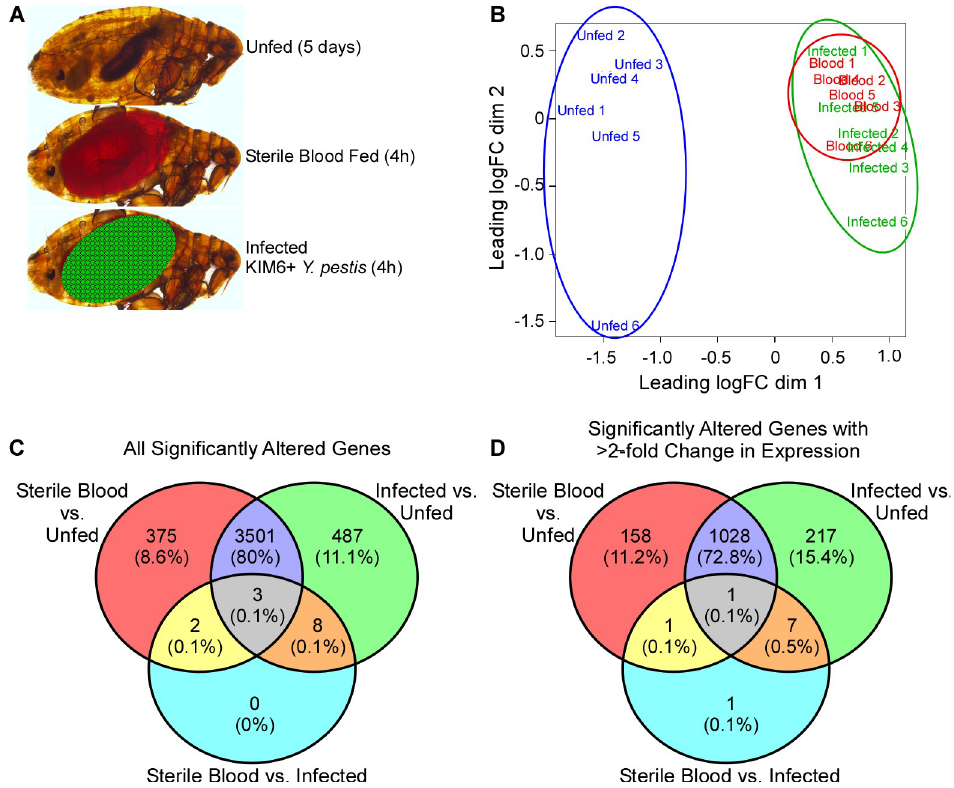
Fig 1. Digestive tract transcriptional profiles of unfed, sterile blood-fed, and infected blood-fed X . cheopis fleas. A) Outline of the three flea treatment groups used for RNA-seq analysis: 1) unfed fleas; 2) fleas fed sterile rat blood; 3) fleas fed infected rat blood (fleas ingested an average of 7x10 4 Y . pestis CFU). B) Multidimensional scaling (MDS) plot of the 6 replicate gene expression profiles for each of the 3 groups: unfed (blue), blood-fed (red), infected (green). Venn diagrams representing C) the number of transcripts with significantly altered expression for 3 comparisons between flea treatment groups (see Table 1) and D) only those transcripts with � 2-fold change in expression.